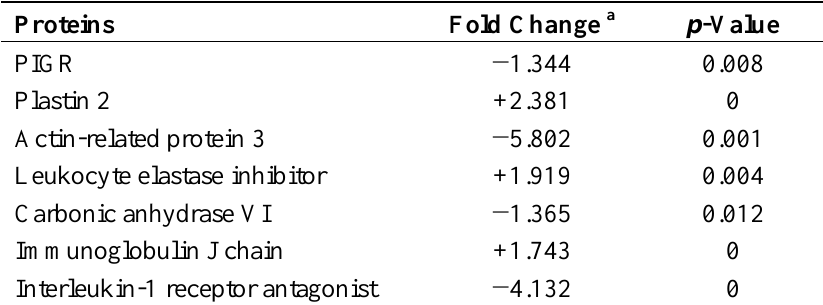
Table 2. List of proteins that were differentially